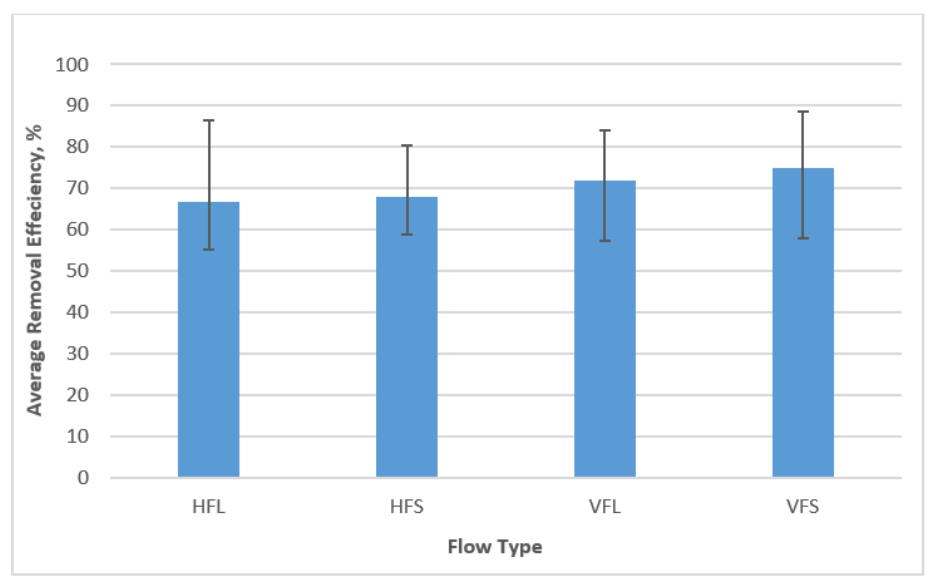
Figure 7. CW systems overall treatment efficiency.